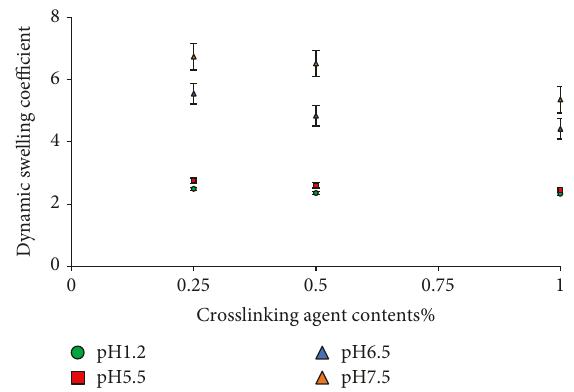
Figure 6: Dynamic swelling coe ffi cient of Poly (CMCS- g -AA) hydrogels with di ff erent contents of EGDMA as crosslinking agent (0.25%, 0.50%, and 1% of AA) in 0.05M USP phosphate bu ff er solutions of di ff erent pH at 37 °